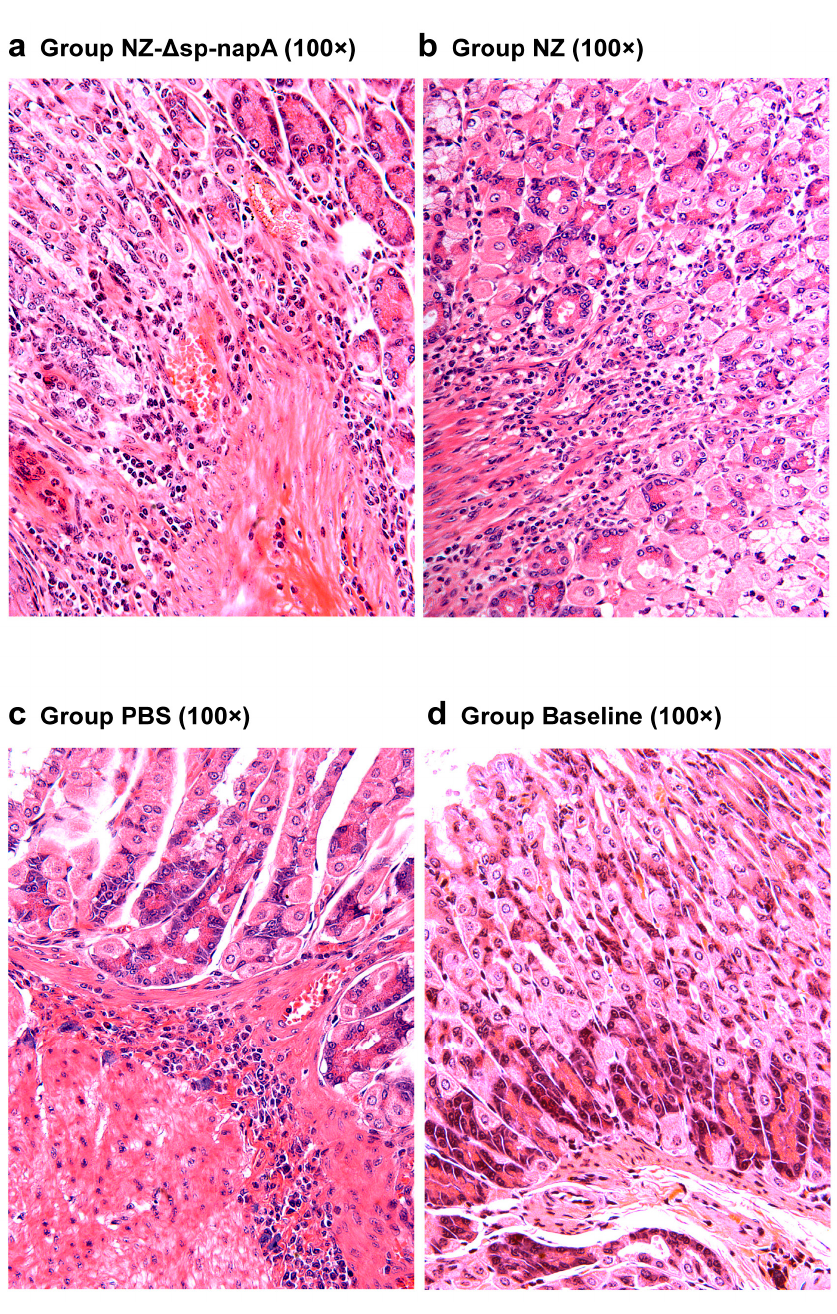
Figure 6. Histological examination of gastric tissues of the LtB-untreated mice. NZ- ∆ sp-napA ( a ), NZ ( b ) and PBS ( c ) groups ( n = 11 each) were gavaged with NZ3900 / pNZ- ∆ sp- napA , NZ3900 / pNZ8110 and PBS, respectively, prior to H. pylori challenges. No gavages were given to the Baseline group ( n = 10) ( d ). The gastric tissues were sampled from the mice 1 week after the challenges and examined via paraffin section and hematoxylin-eosin staining. The mice of all the H. pylori -challenged groups had gastric inflammatory responses characterized by the infiltration of lymphocytes, neutrophils and microphages, abscess, and congestion in gastric mucosa and submucosa.